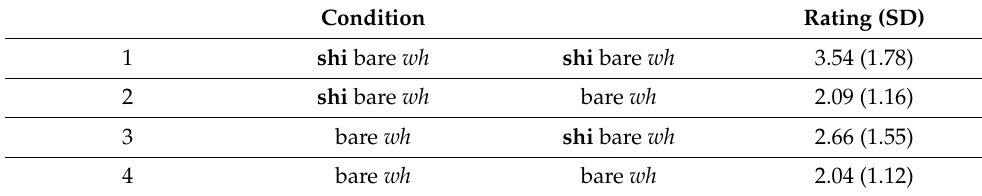
Table 6. Mean acceptability ratings in sub-experiment